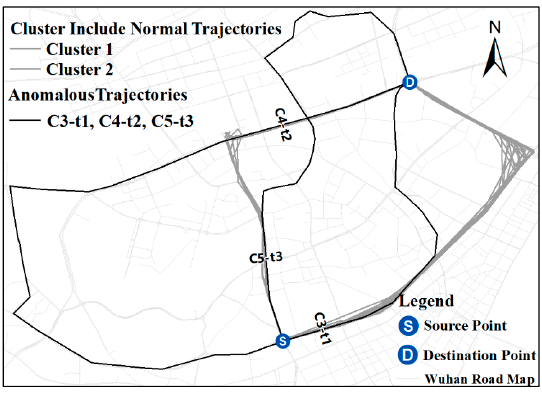
Figure 2. Illustration of all the taxi trajectories between source and destination.